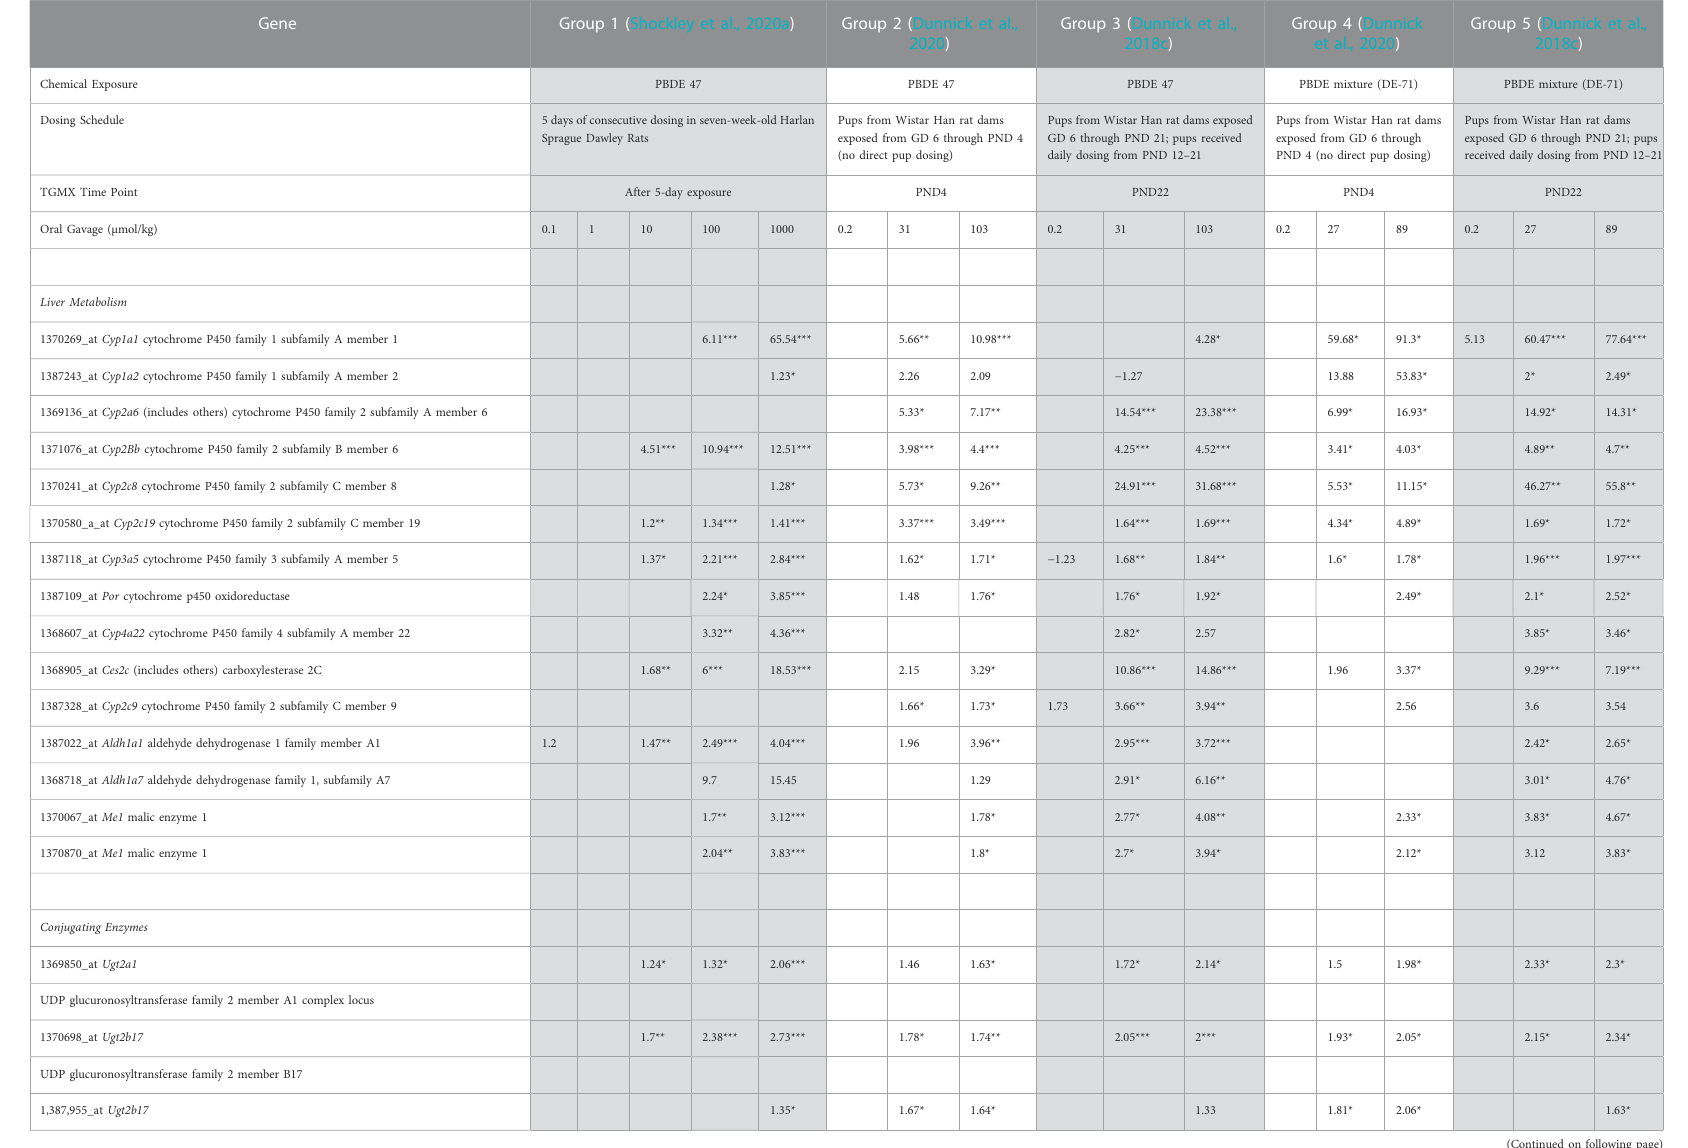
TABLE 3 Selected PBDE-induced liver transcript alterations associated with metabolic, membrane, NRF2 pathway, and lipid function and cancer pathways.